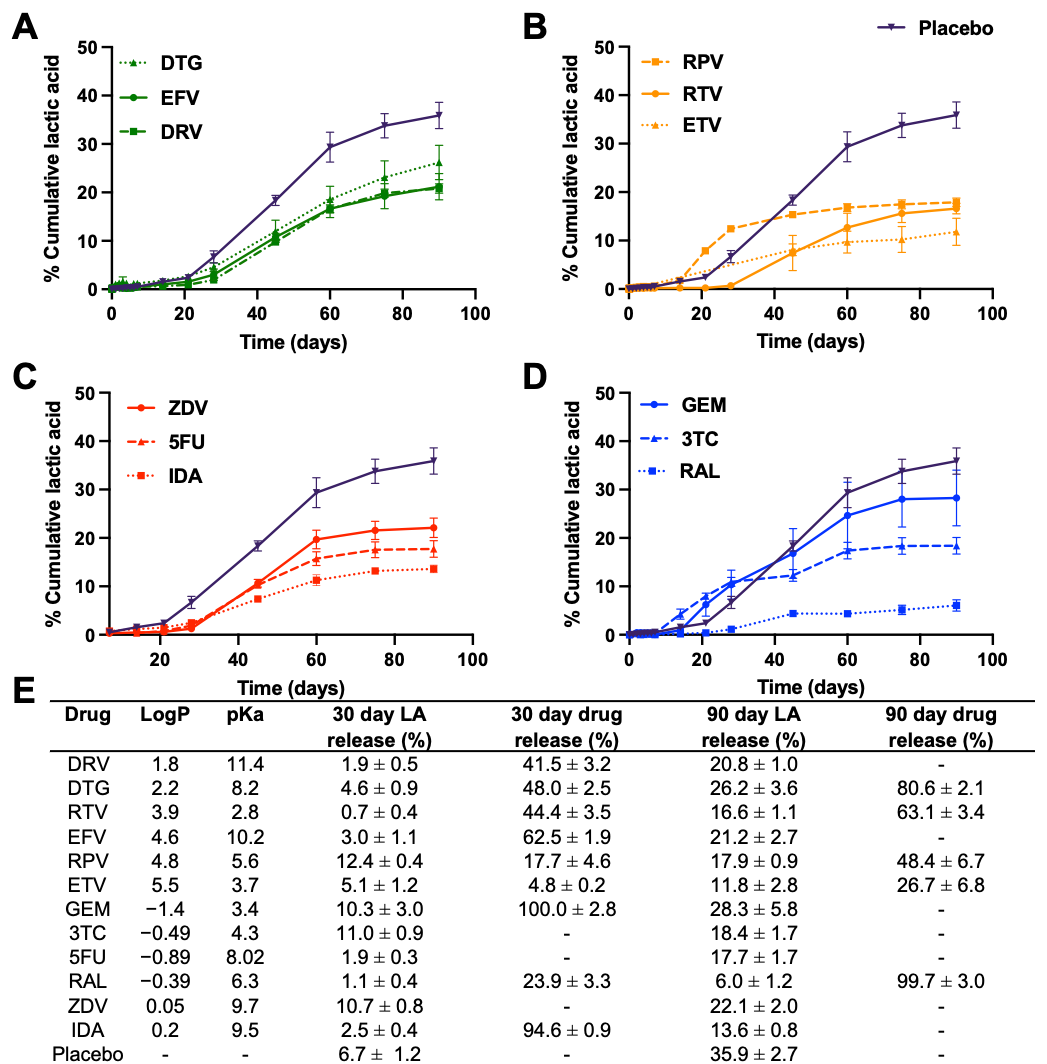
Figure 4. Cumulative percentage in vitro LA release kinetics from drug-loaded ISFIs (50 mg/g